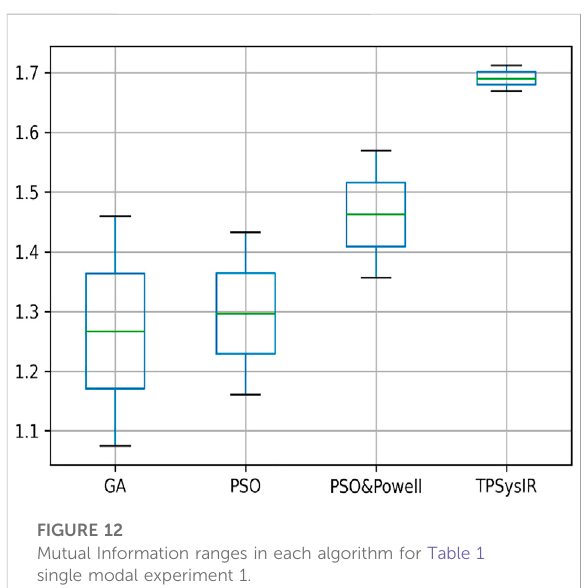
FIGURE 12 Mutual Information ranges in each algorithm for Table 1 single modal experiment